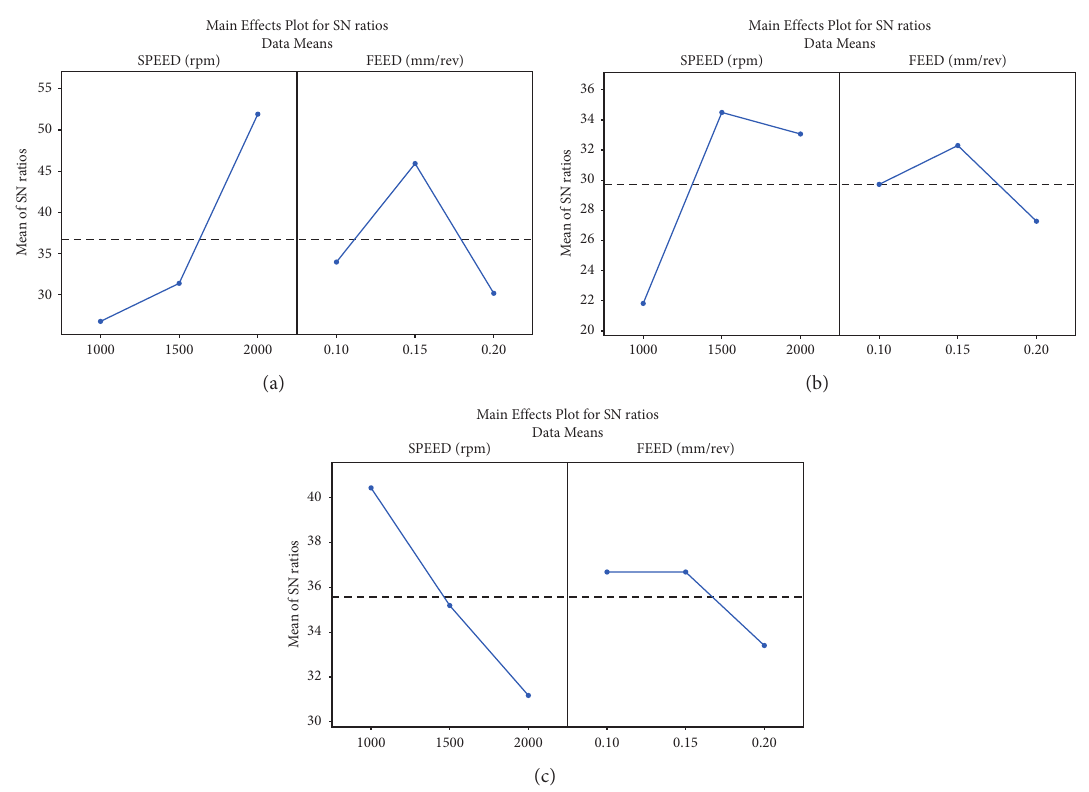
Figure 5: Signal-noise ratio of (a) candlestick, (b) twist, and (c) step cone drill bits during the drilling process.